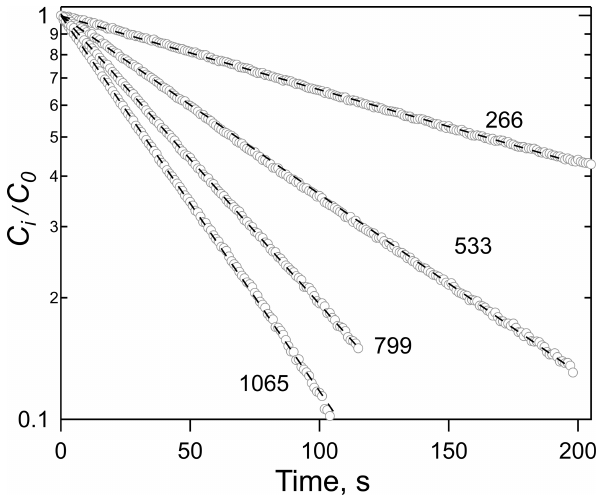
Figure 1. Plots of the ratio of HNCO concentration at time t , C i , to the initial concentration, C o , versus time for a series of flow rates, noted as ambientcm 3 min − 1 . The solvent was tridecane (C 13 H 28 ) at 299K.